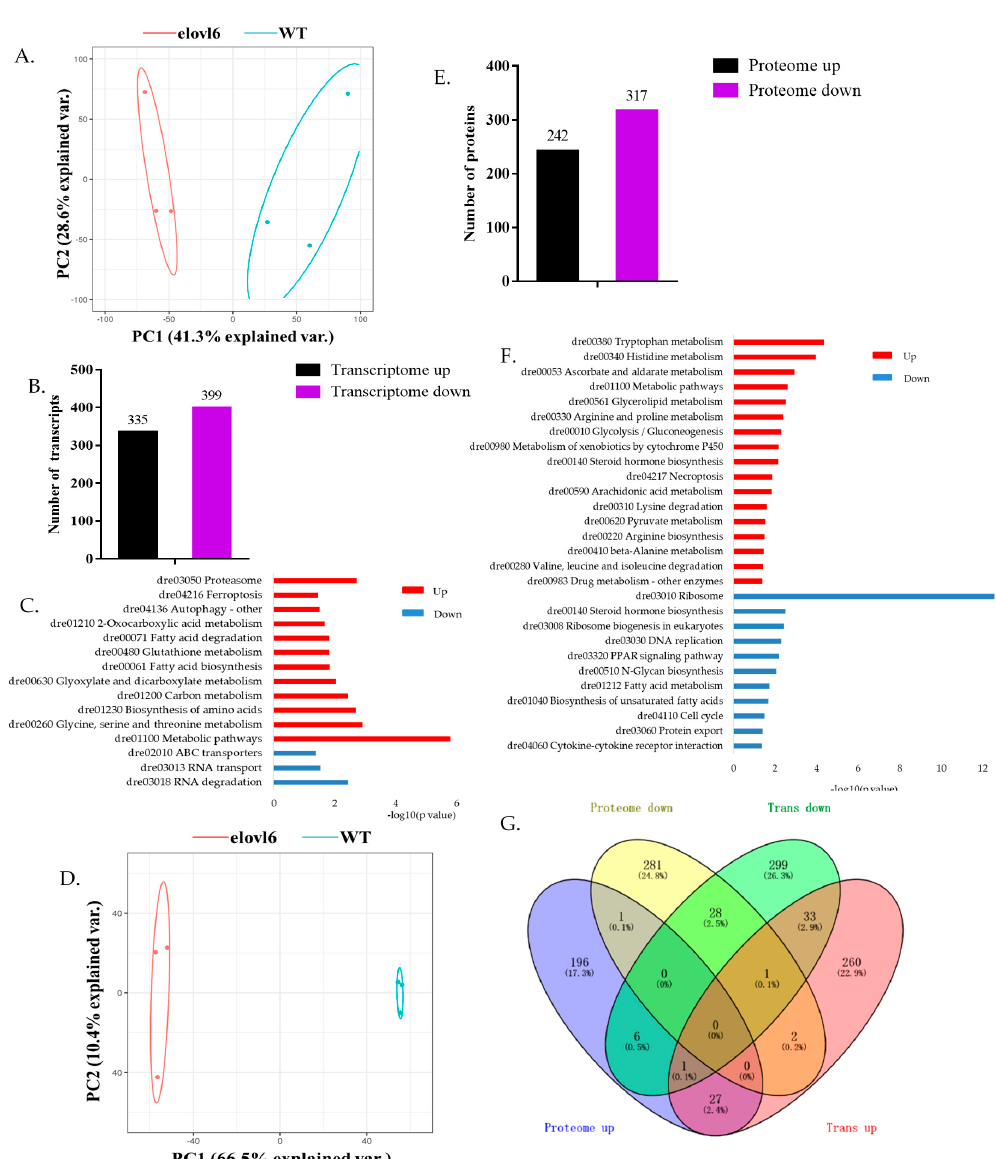
Figure 2. Comparative analyses of hepatic transcriptomics and proteomics between elovl6 − / − and WT zebrafish and the integrated analysis of transcriptomics and proteomics. ( A ) The principal component analysis (PCA) at the transcriptomic level for a total of six samples of the elovl6 − / − and wild type (WT) zebrafish. ( B ) Up- and down-regulated DEG in elovl6 − / − zebrafish in comparison to WT. ( C ) Analysis of KEGG pathway enrichment of DEG to understand the biologic processes. ( D ) The principal component analysis (PCA) at the proteomic level for a total of six samples of the elovl6 − / − and WT zebrafish. ( E ) Up- and down-regulated DEP in elovl6 − / − zebrafish in comparison to WT. ( F ) Analysis of KEGG pathway enrichment of DEP to understand the biologic processes. ( G ) Overlap between DEP and DEG. DEG, differentially expressed genes; DEP, differentially expressed proteins; elovl6 , elongation of very long chain fatty acids protein 6; KEGG, Kyoto Encyclopedia of Genes and Genomes; elovl6 , elongation of very long chain fatty acids protein 6.